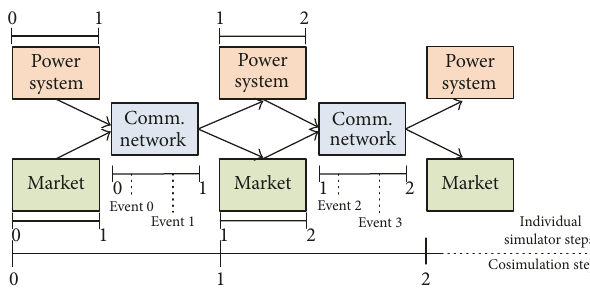
Figure 5: Synchronization scheme of simulators at cosimulation time